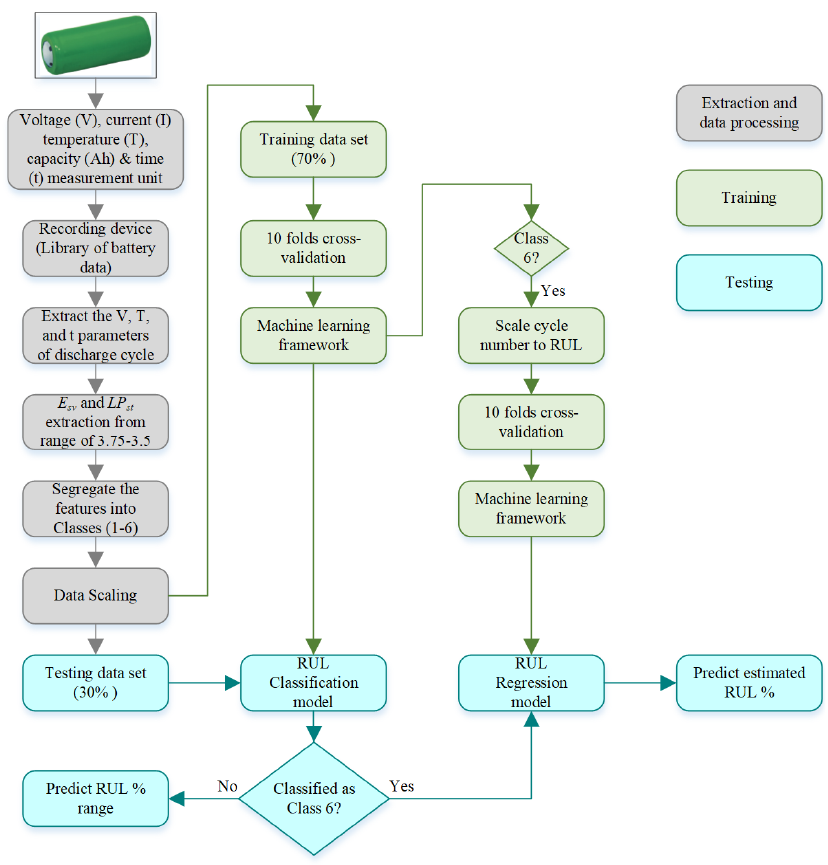
Figure 4. General flow chart of training and testing of classification and regression models for RUL prediction.